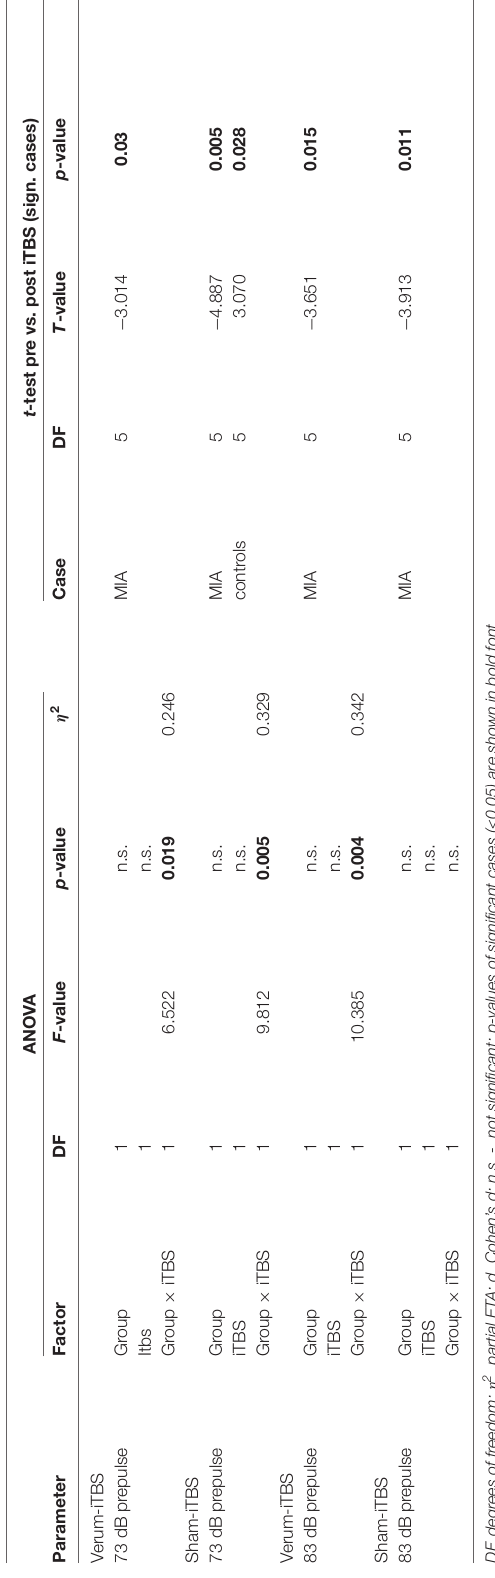
and verum-iTBS, although somewhat better after verum-iTBS ( Figure 2M ). ANOVA conducted with factors iTBS and GROUP resulted in a significant effect of factor iTBS only ( F (2,42) = 12.697; p < 0.001; η 2 = 0.377) without interaction between these